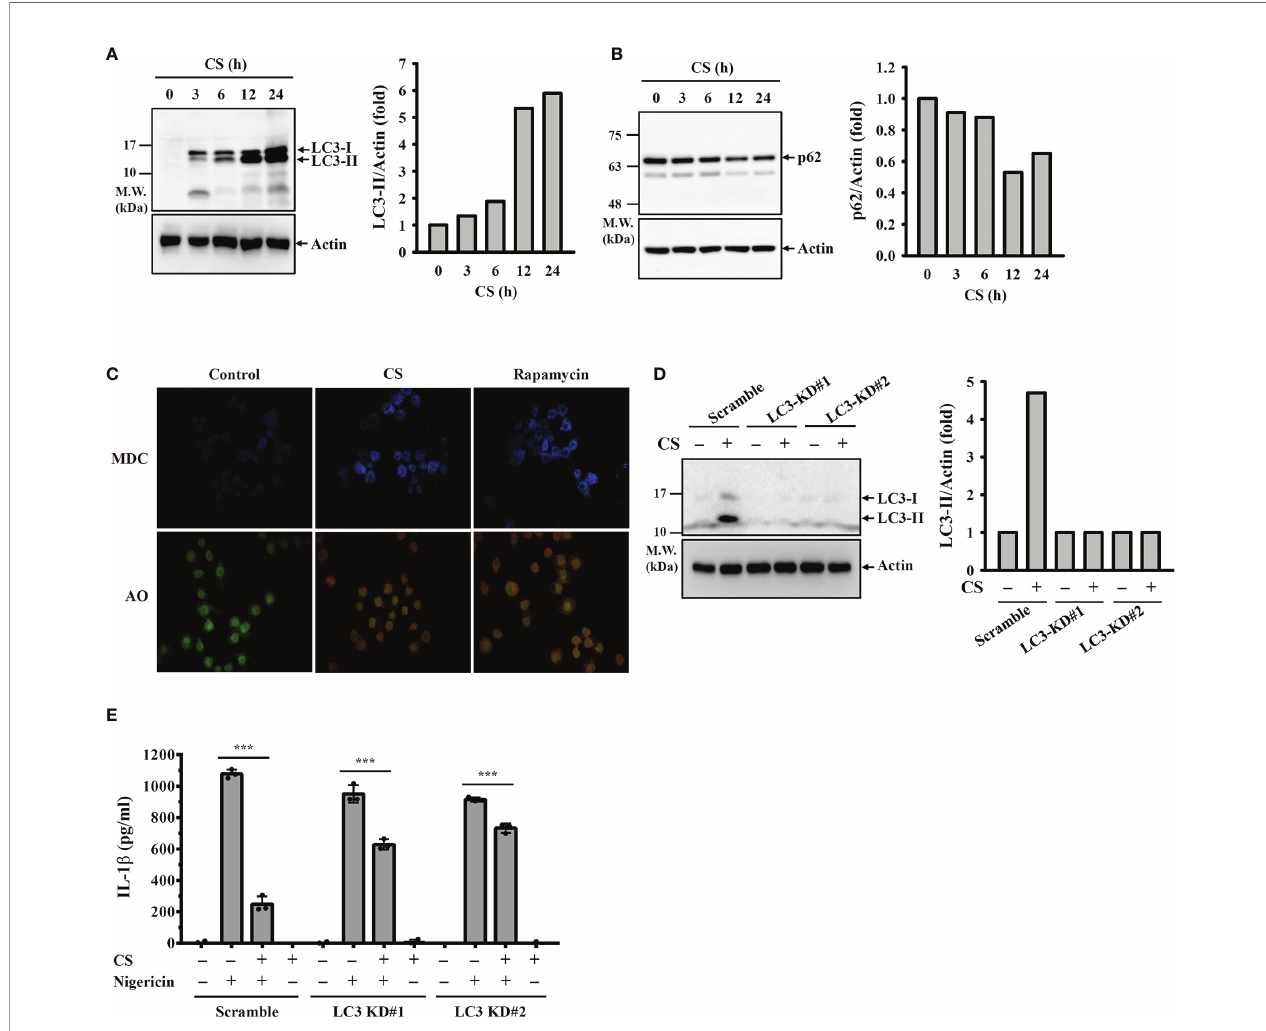
FIGURE 6 | CS inhibits the NLRP3 in fl ammasome partially through autophagy induction. (A, B) J774A.1 macrophages were incubated with CS for 0-24 h The levels of LC3 (A) and p62 (B) in the cell lysates were measured by Western blot. (C) J774A.1 macrophages were incubated with 15 m M CS for 6 h or 100 nM rapamycin for 4 h The autophagic response was measured by MDC and AO staining. (D) Scramble control or LC3 knockdown J774A.1 macrophages were incubated with 15 m M CS for 24 h The levels of LC3 in the cell lysates were measured by Western blot. (E) Scramble control or LC3 knockdown J774A.1 macrophages were primed with LPS for 5 h and incubated with CS for 6 h Cells were stimulated with 10 m M nigericin for 0.5 h. The levels of IL-1 b in the supernatants were measured by ELISA. The ELISA data are expressed as the means ± SD of the three separate experiments. The Western blot images are representative results, and the histogram shows the band intensity. *** indicates a signi fi cant difference at the level of p <0.001 as